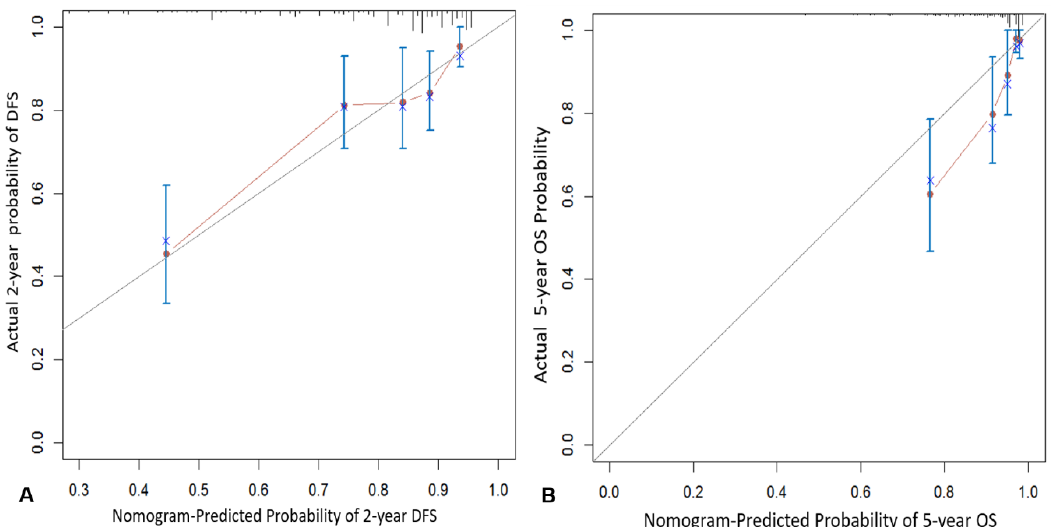
Figure 2. The calibration curve for predicting the 2-year disease-free survival ( A ) and 5-year overall survival ( B ).